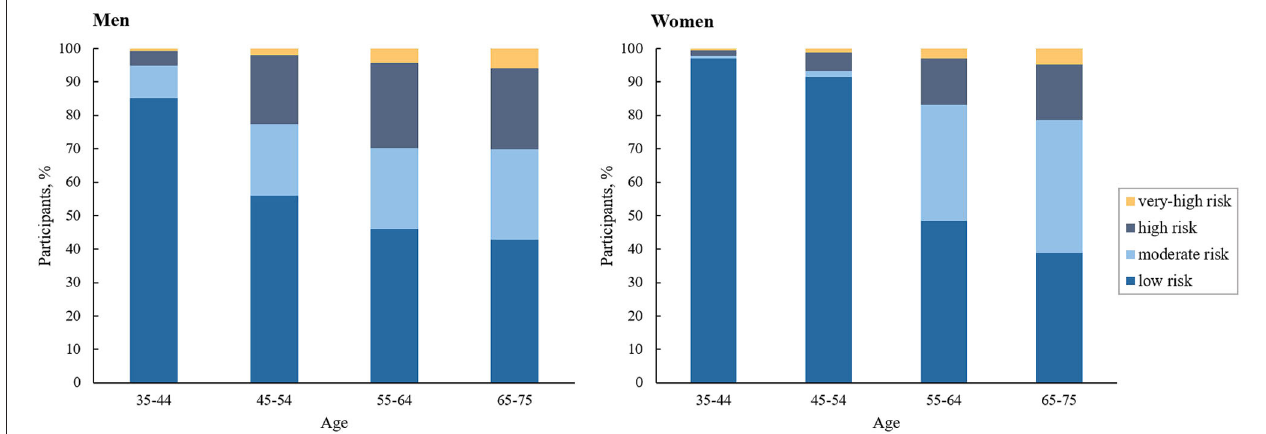
FIGURE 2 | Proportion of participants at different 10-year ASCVD